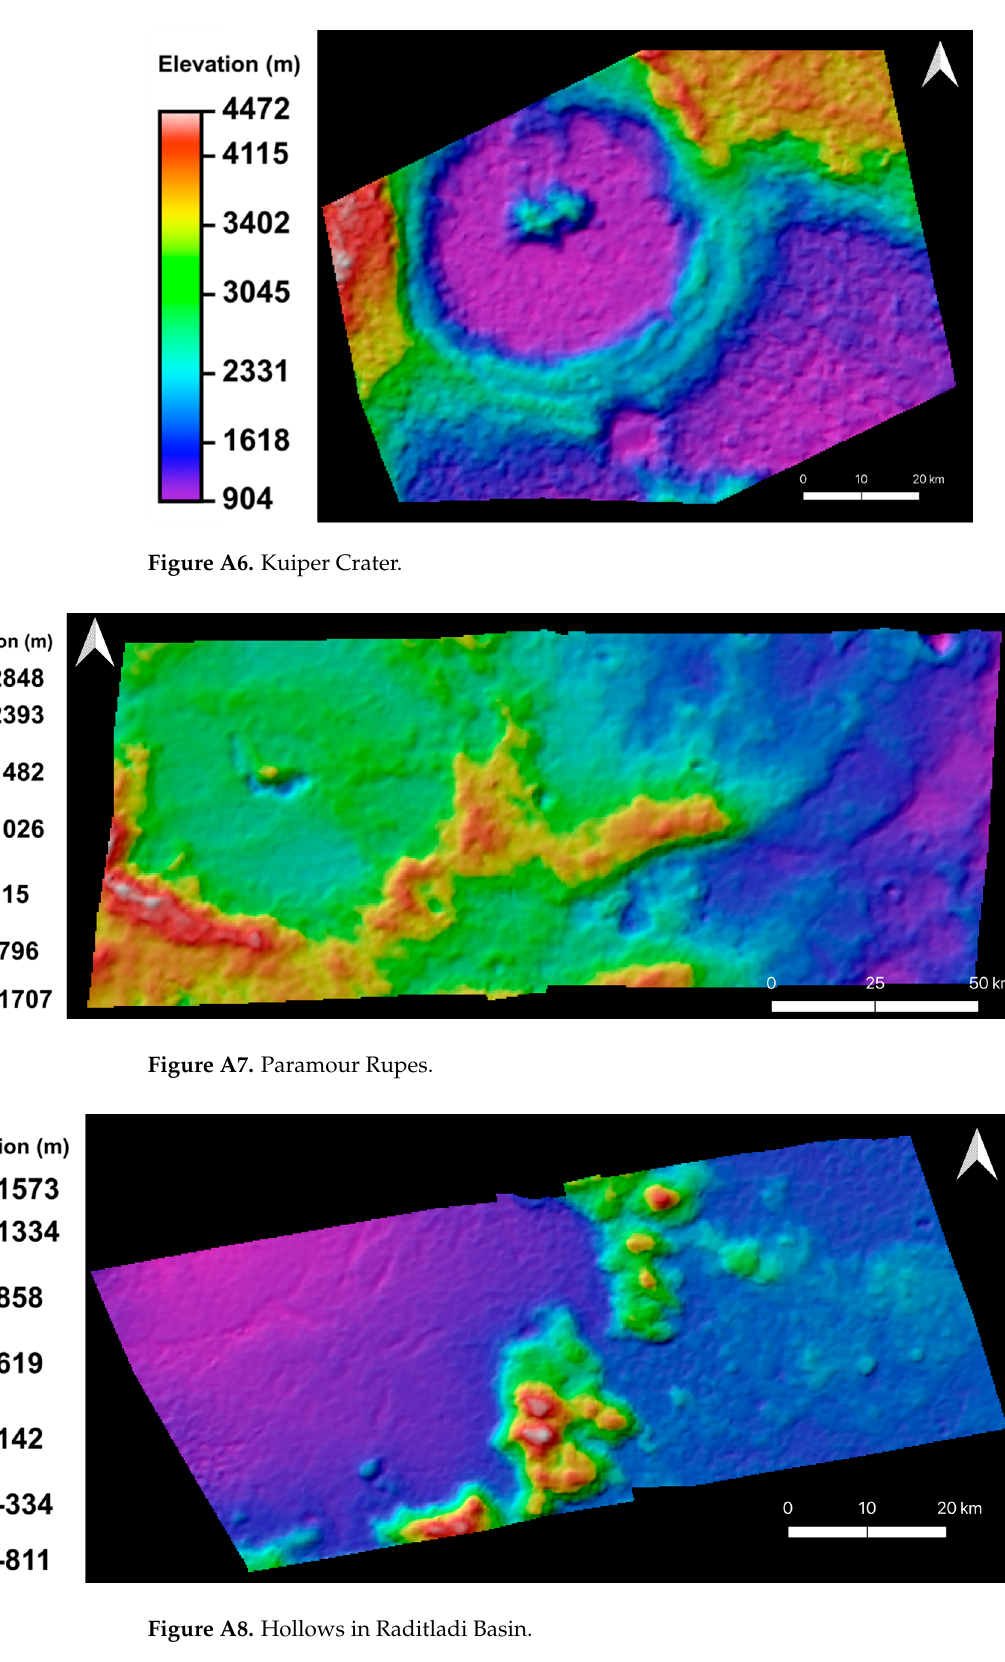
Figure A9. Sander Crater. Appendix C Anaglyphs of DEMs containing hollowed regions. Note that anaglyphs are vertically exaggerated by approximately 10× the true vertical distance.